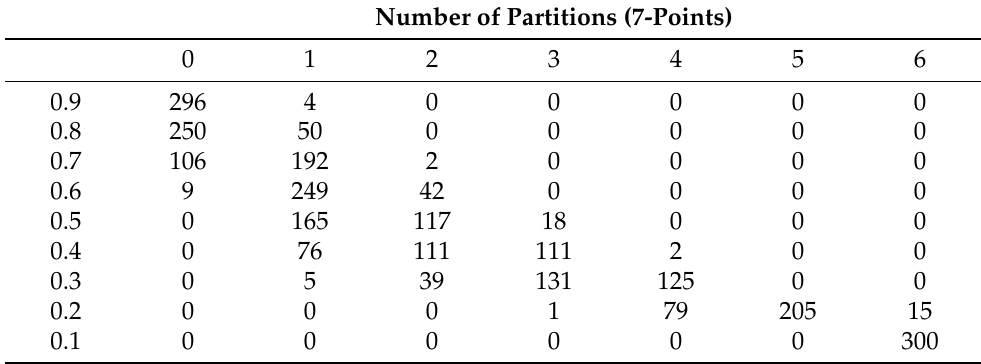
Table 7. Number of partitions using a 7-Likert